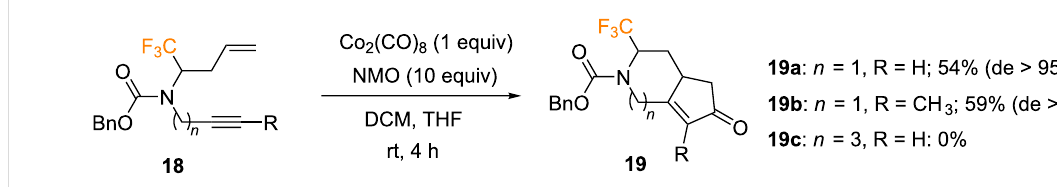
Scheme 8: Intramolecular PKR of 1,7-enynes reported by the group of Billard [47].